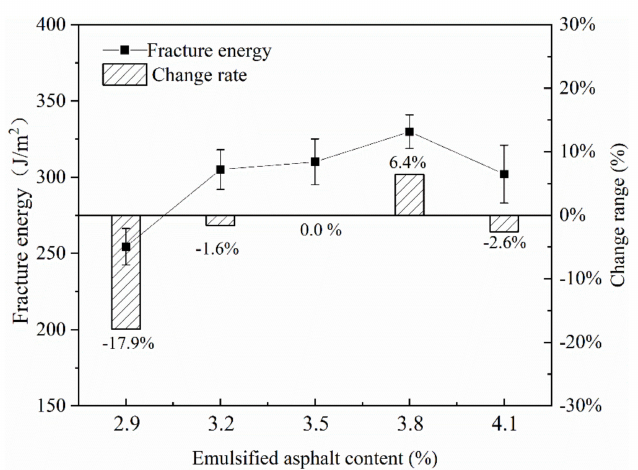
Figure 11. E ff ect of emulsified asphalt content on fracture energy.